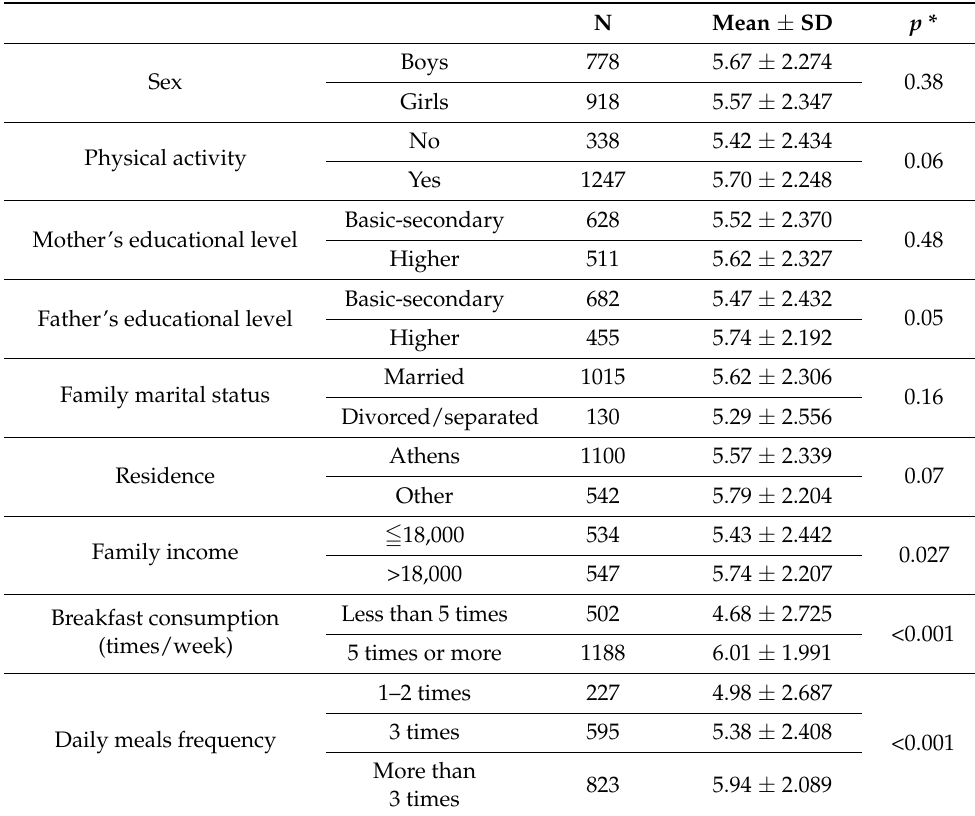
Table 4. Weekly milk consumption per several children’s